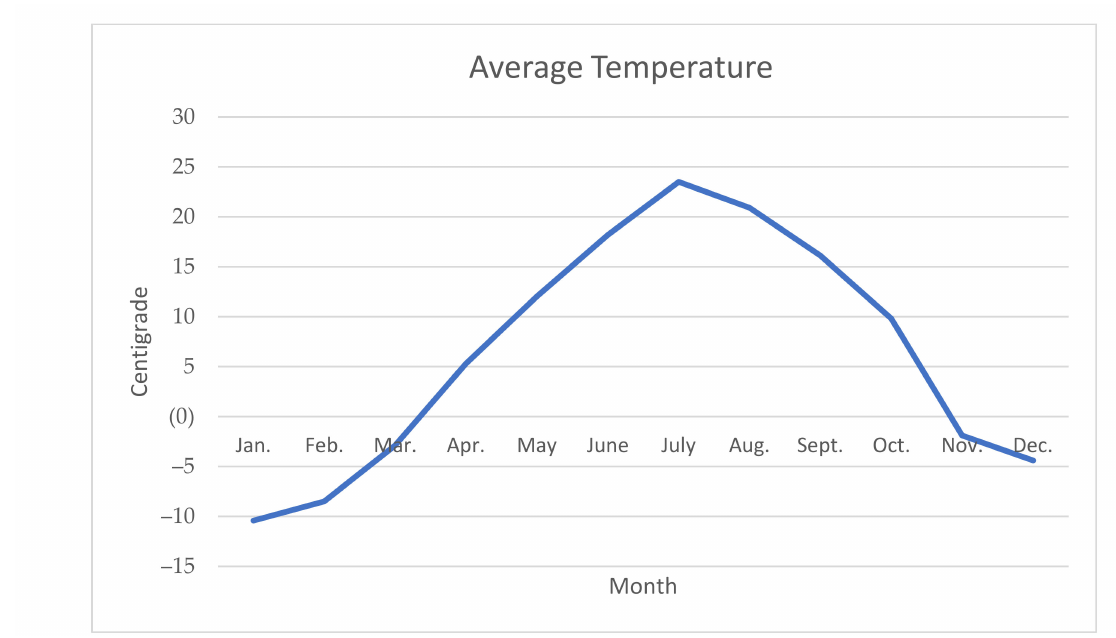
Figure 5. Montreal monthly average temperature in 2019.